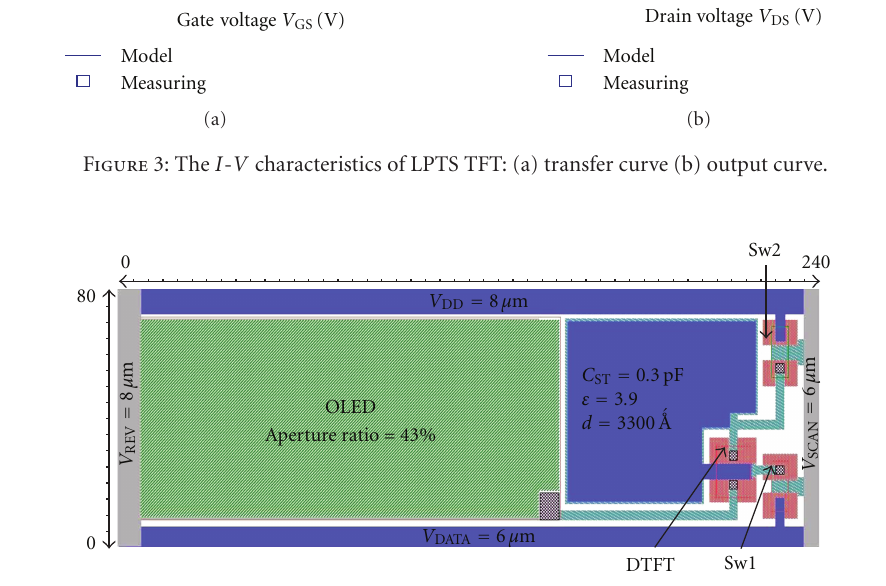
Figure 4: The layout of the proposed pixel